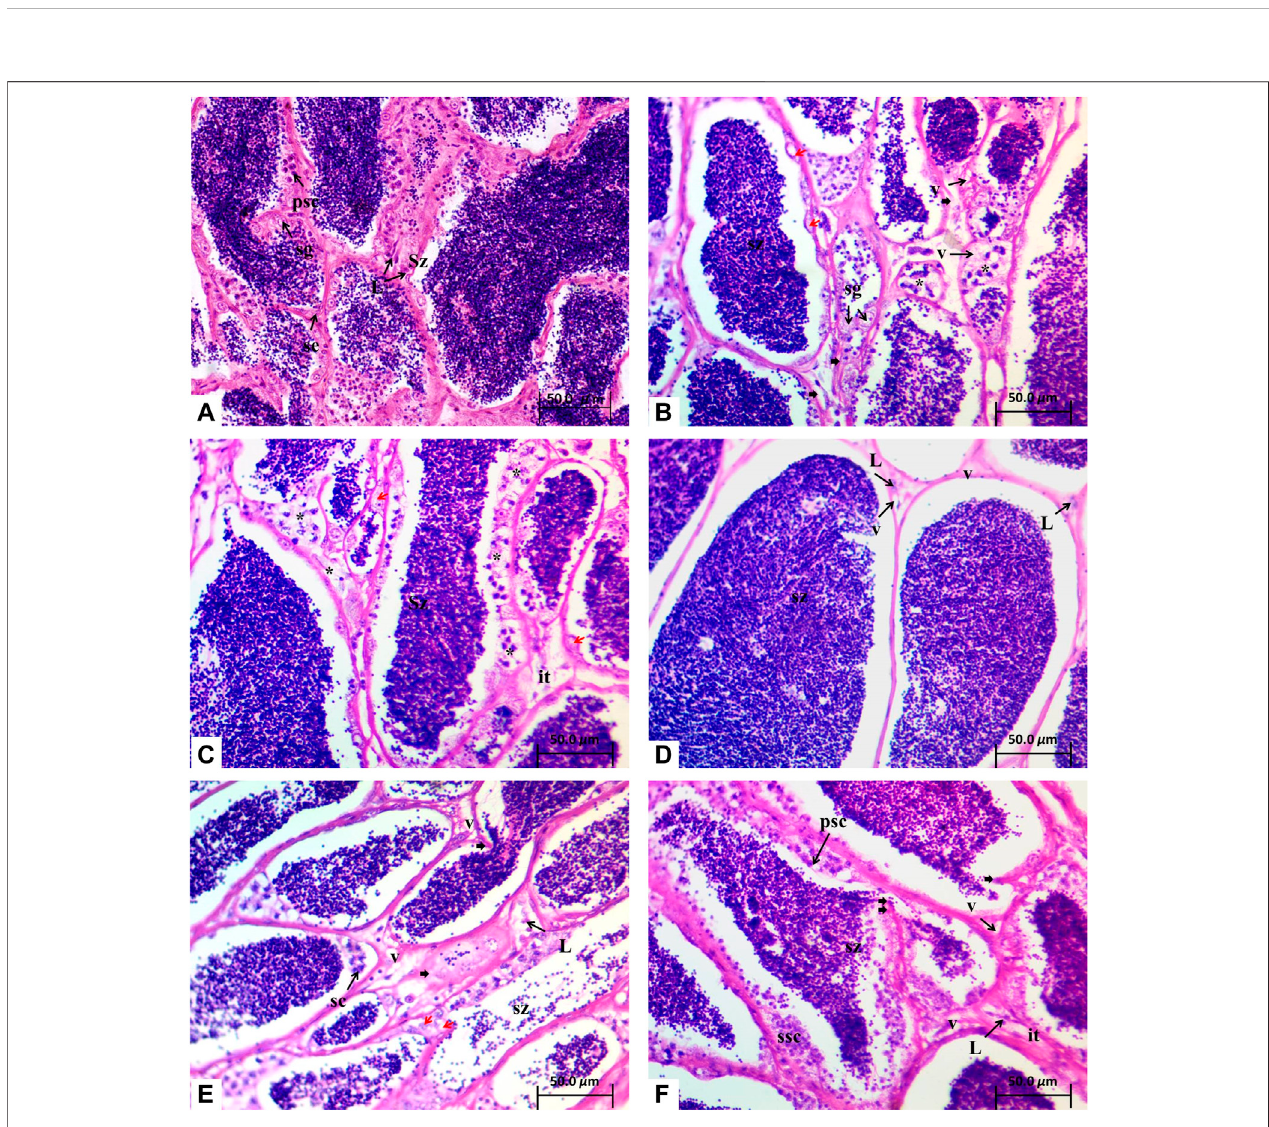
FIGURE 2| Testes tissues of C. gariepinus after exposure to microplastics for 15 days: (A) control (ctr) fi sh group with fully developed mature testis with nests of spermatogonia (sg) along the lobule wall, primary spermatocytes (psc), Leydig cells (L), and Sertoli cells (Se) and fi lled with mature spermatozoa (Sz). (B – C) microplastics-exposed group (MPs) with disorganized lobule structure (black arrow heads), vacuolation of interstitial tissue (v), hypertrophied spermatogonia (red arrow) and less amount of spermatozoa (Sz), degeneration of germ cells (*) and diminished interstitial cells (it), and degenerated Leydig cells (L). (D) Lycopene- exposed group (lyco) with normal amounts of spermatozoa (Sz), few vacuoles (v), and Leydig cells (L). (E) Citric acid-exposed group (citr) with less amount of spermatozoa (Sz), disorganized lobule structure (black arrow heads), vacuolated interstitial tissue (v), hypertrophied spermatogonia (red arrow), and degenerated Leydig cells (L). (F) Chlorella -exposed group (chl) with lobules occupied with spermatozoa (Sz) and interstitial tissue (it) with few vacuoles (v) and Leydig cells (L), disorganized lobule structure (black arrow heads), secondary spermatocytes (ssc), hematoxylin – eosin staining.